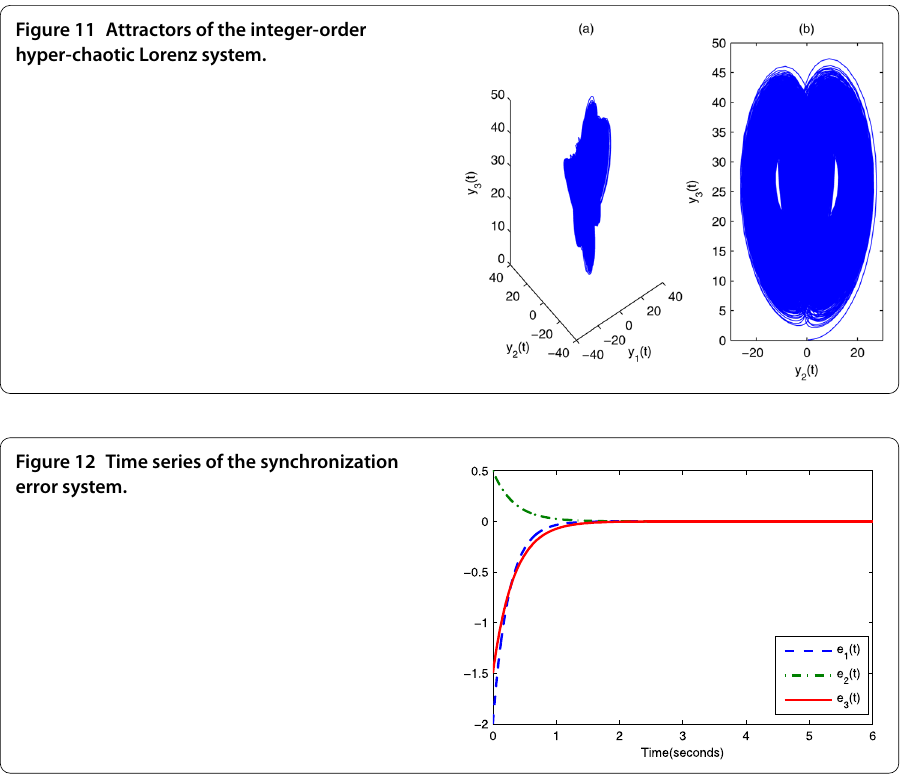
Figure 11 Attractors of the integer-order hyper-chaotic Lorenz system.